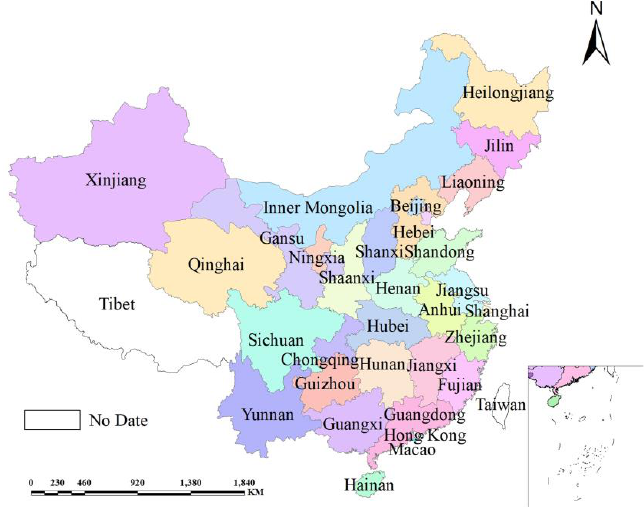
Figure 1. Study areas.